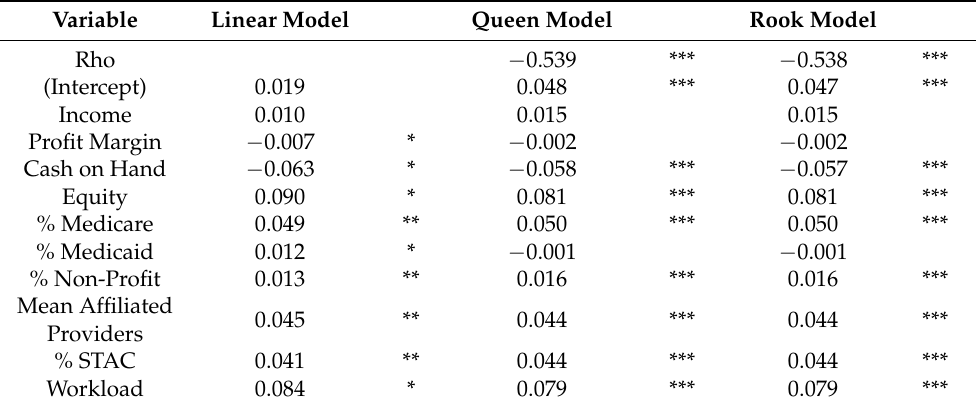
Table 6. Regression table for county